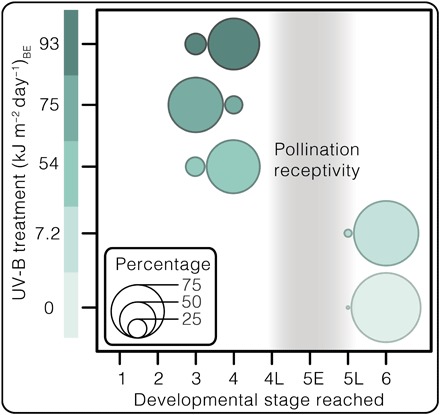
UV-B impacts on ovulate cone survivorship in pine (P. mugo).Bubble chart displaying P. mugo ‘Columnaris’ ovulate cone survivorship by displaying the percentages of cones reaching their furthest developmental stage per treatment population (n = 48 to 60). See table S4 for ovulate cone data.